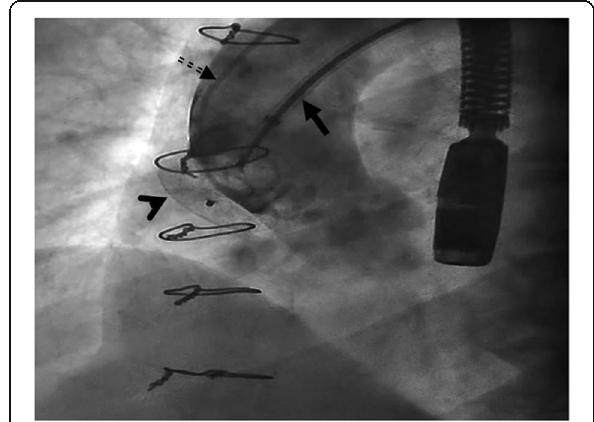
Fig. 4 Flouroscopy during aortic root injection Before complete release of ASD occluder, revealed good position of device and total occlusion of pseudoaneurysm inlet. Arrowhead: ASD occluder. Arrow: device cable. Dash arrow: Pigtail catheter for aortic root injection